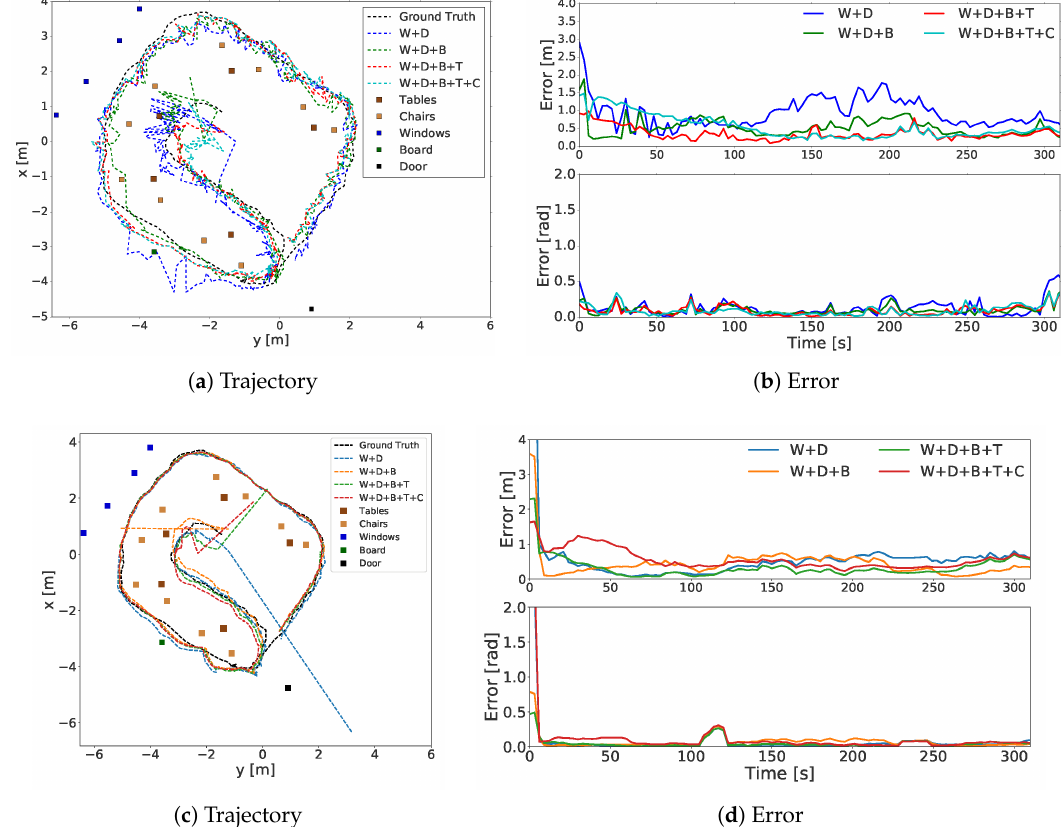
Figure 6. Trajectories and errors of sensor models using different object classes. Sensor models used different combinations of W (window), D (door), B (board), T (table) and C (chair) object classes. Subfigures ( a , b ) show the trajectory and errors of the sensor model using different object class combinations, respectively. Subfigures ( c , d ) show the trajectory and errors corresponding to the sensor model using the ground truth for object